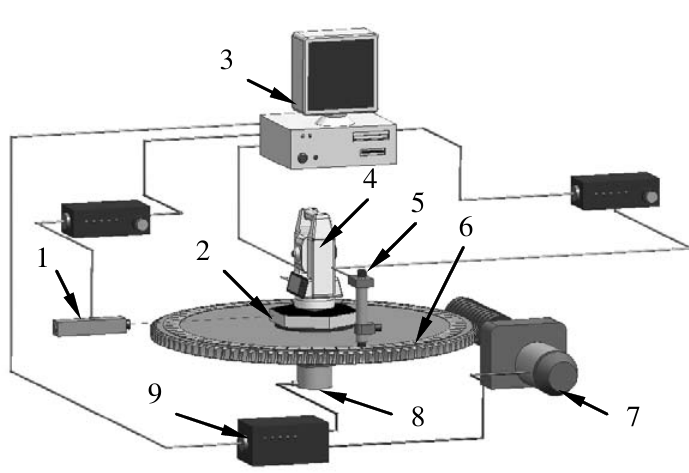
Fig 1 . General diagram of the test